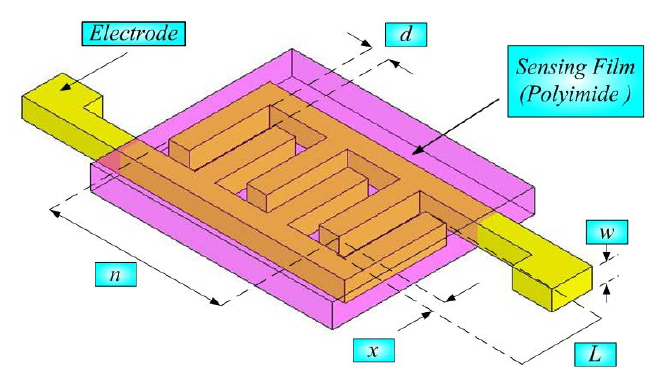
Figure 2. Structure of micro humidity